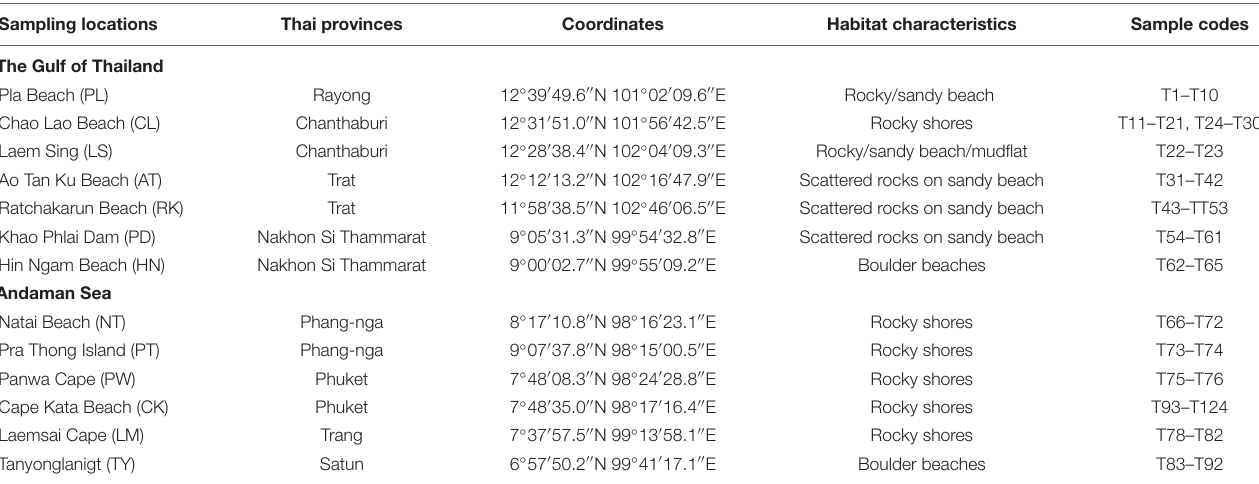
TABLE 1 | Sampling locations and habitat